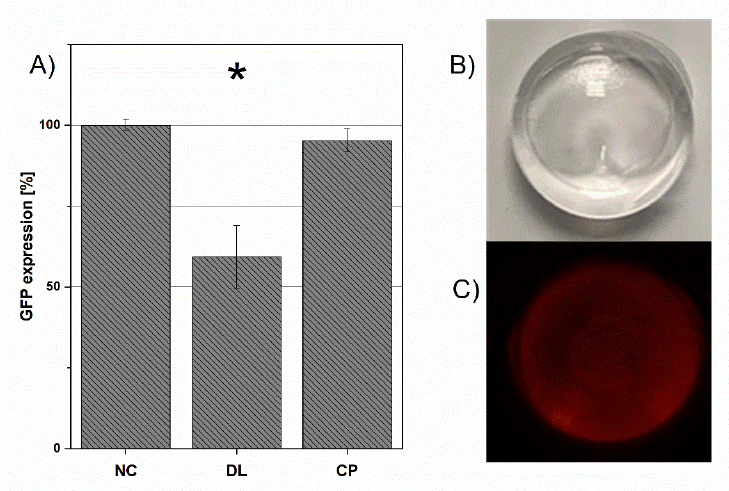
Figure 3. ( A ) represents the GFP expression level of the negative control (NC) group, DL and CP. Significant results ( p < 0.5) is marked by *. Figure 3B,C show lipoplex-siRNACy3 loaded hydrogels in bright light ( B ) and excitated at a wavelength of 550 nm ( C ). Fluorescence imaging was used to assess the lipoplex-siRNACy3 distribution in the hydrogel (Figure 3B). After loading, the siRNA-Cy3 emission is homogeneously distributed.